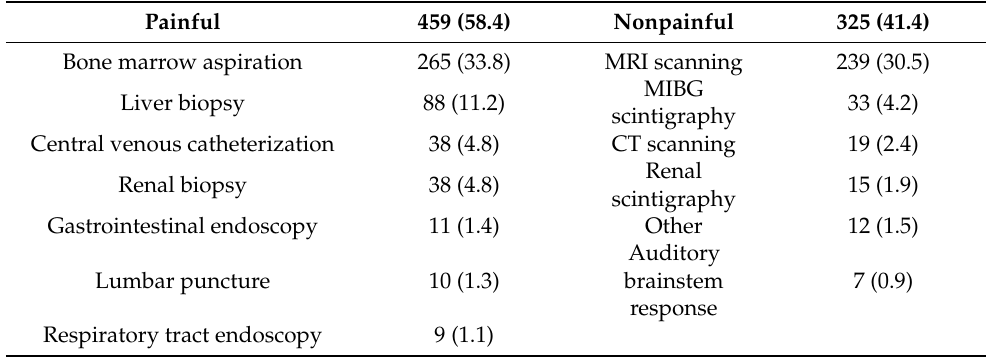
Table 2. Performed